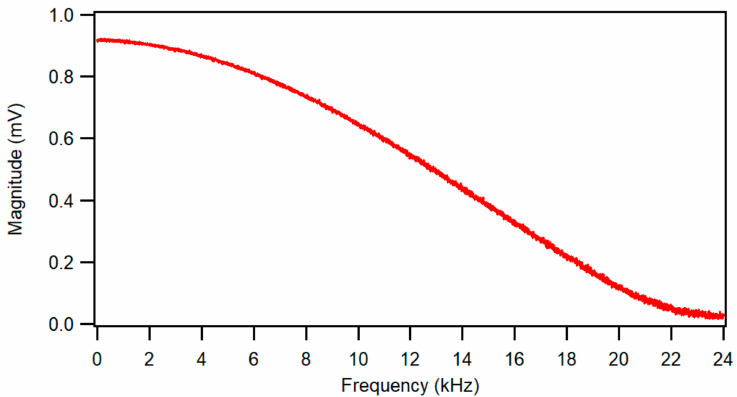
Figure 4. Frequency spectrum of the pulse